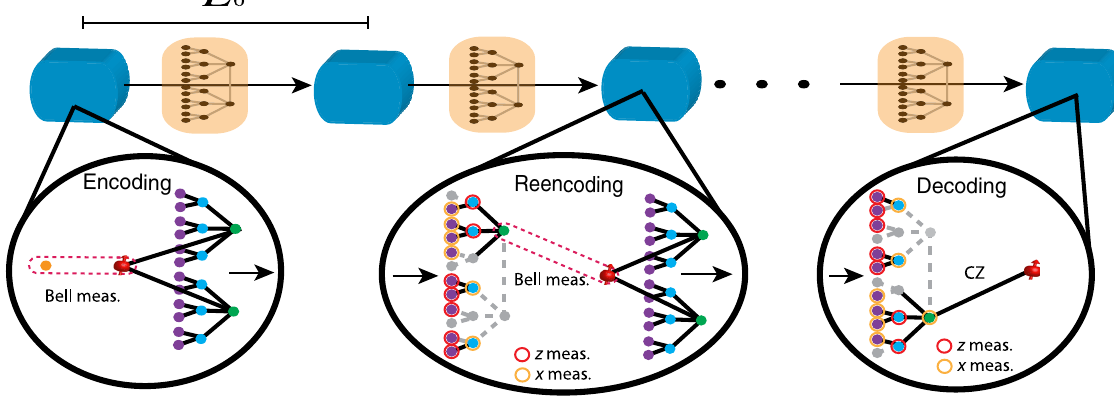
FIG. 1. Sketch of a one-way quantum repeater with photonic tree clusters. A message qubit (orange dot) is encoded through a Bell measurement (dashed box) with the root spin qubit of a photonic tree cluster. An example with a [2,3,2] tree is shown where dots correspond to photonic qubits and solid lines indicate correlations. The encoded qubit (depicted in the orange boxes) is sent a distance L 0 to the next repeater station. At the next repeater station, the qubit information is reencoded through a Bell measurement between one of the first-level photonic qubits and the root spin qubit of a new tree. The remaining qubits of the incoming tree are measured with single qubit z (red circle) or x (orange circle) measurements. The reencoding can succeed despite multiple photons being lost in transmission (gray dots and dashed lines). At the end station, the message qubit can be transferred to, e.g., a receiving spin qubit by means of a controlled-phase ( CZ )